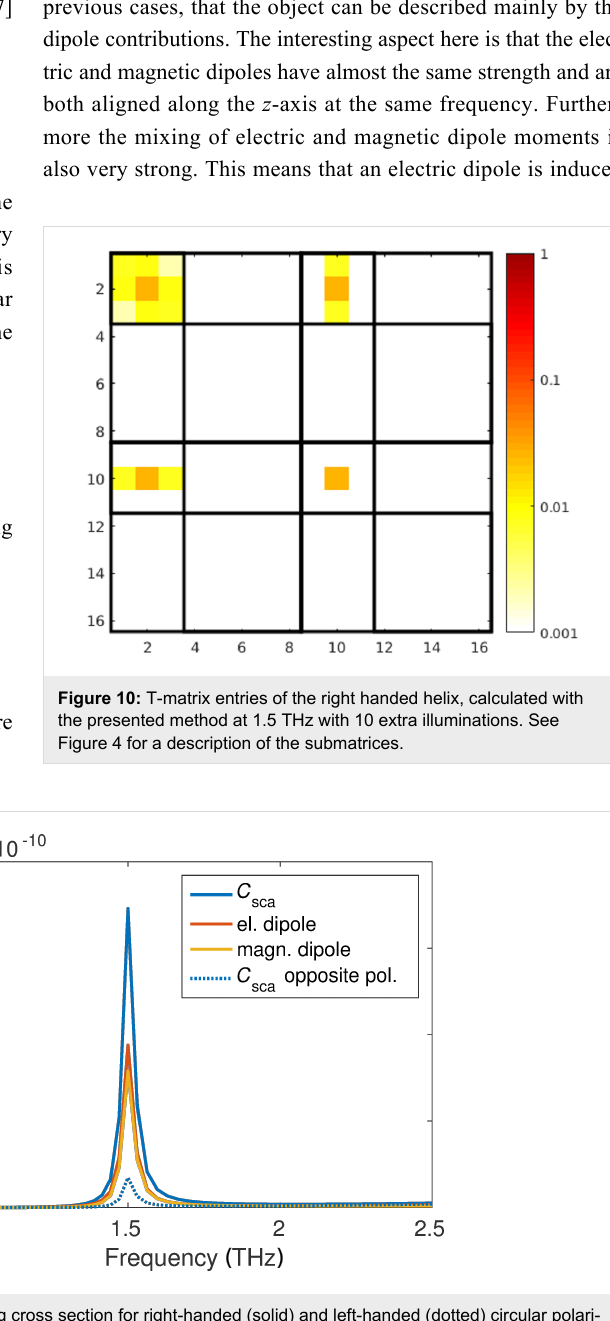
Figure 9: Right-handed metallic helix with two windings. Total scattering cross section for right-handed (solid) and left-handed (dotted) circular polari- zation. The electric and magnetic dipole contributions are approximately equal. On the left side we display the geometry and illumination direction of the helix.